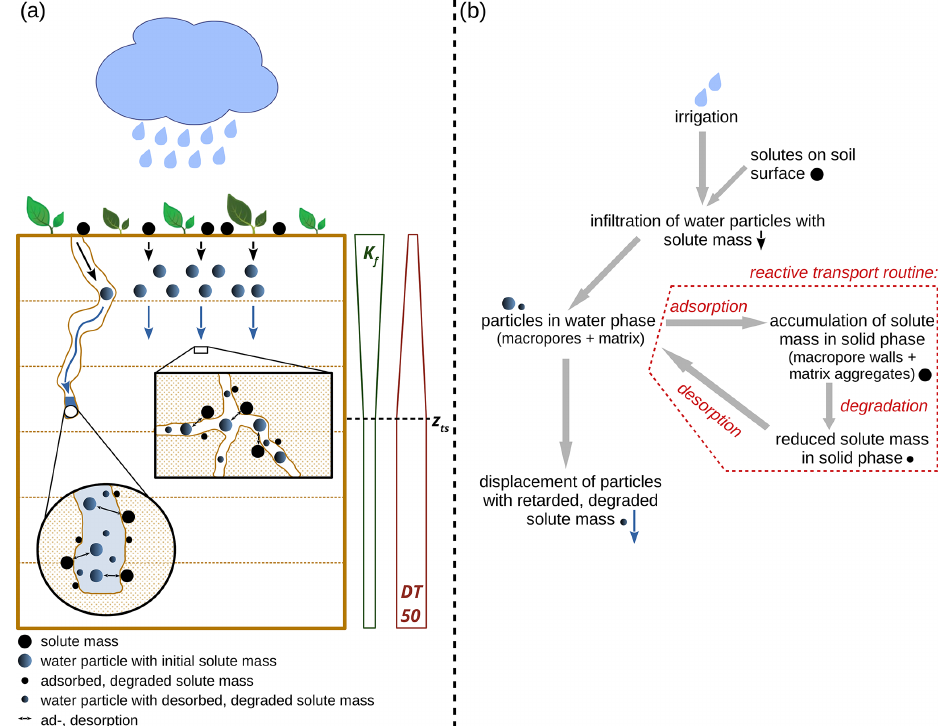
Figure 3. (a) Overview sketch of sorption and degradation processes in the soil domain. Down to the predefined depth z ts (m), we assume the topsoil with linearly decreasing K f and linearly increasing DT50 values to account for the depth dependence of sorption and degradation, respectively. Below z ts in the subsoil, we assume constant values. (b) Flow chart to illustrate the sequence of reactive solute transport. The pictograms of the sketch are assigned to the respective positions and steps of the flow